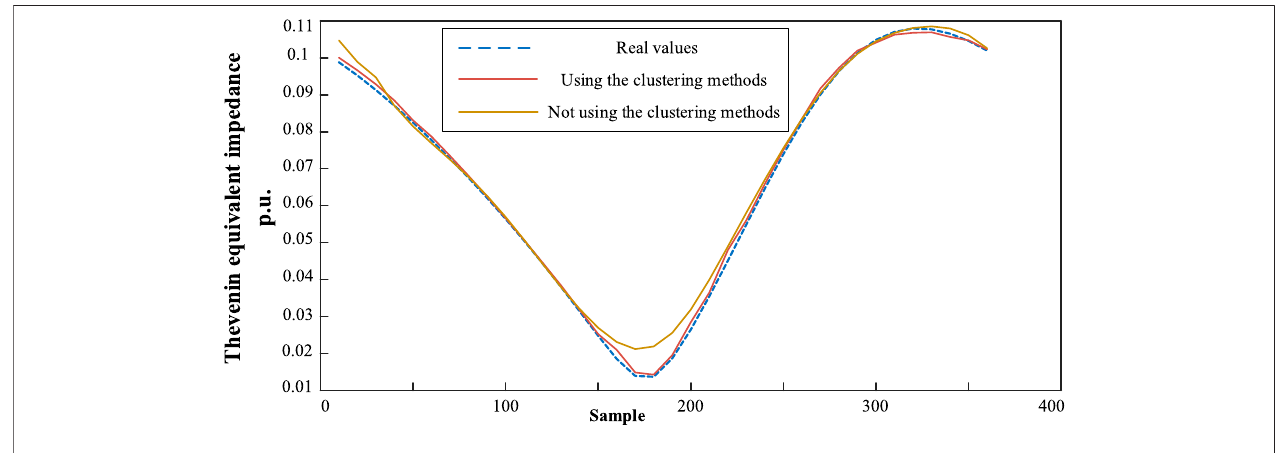
FIGURE 8 | Comparison of using the NGC clustering processing method.